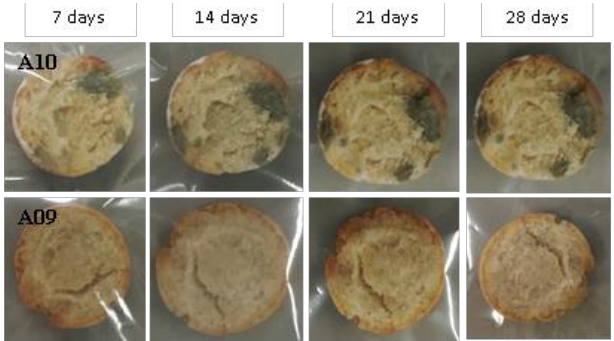
Figure 14. Examples of bread made from sourdoughs inoculated with the dual combination of isolates A10 and A09, then artificially contaminated with Penicillium expansum and incubated at room temperature for 7, 14, 21, and 28 days.